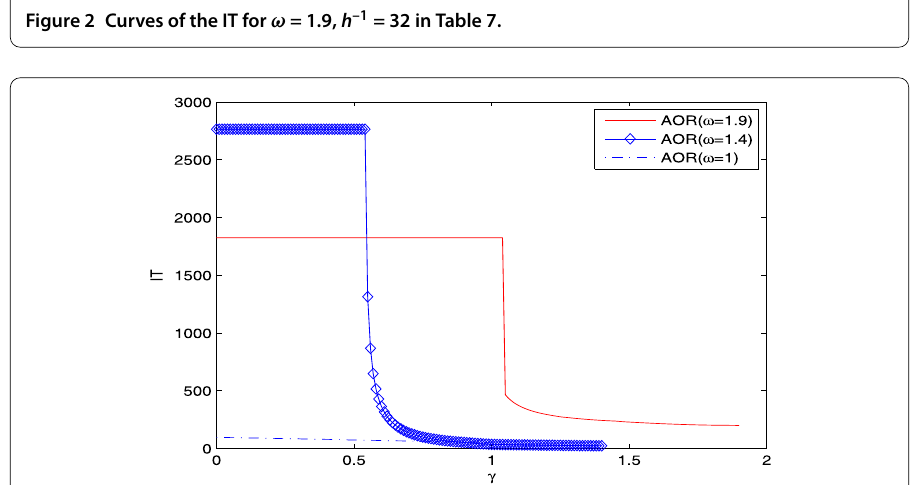
Figure 3 Curves of the IT for ω = 1.9, ω = 1.4, and ω = 1 with h –1 = 32 in Table